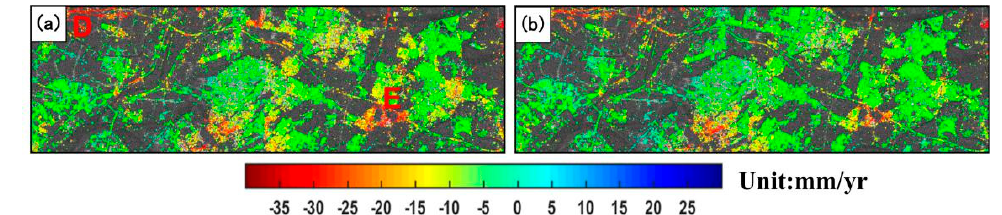
Figure 13. The average velocity maps over G1501 Highway generated by two models. ( a ) Linear model result; ( b ) Seasonal model result.